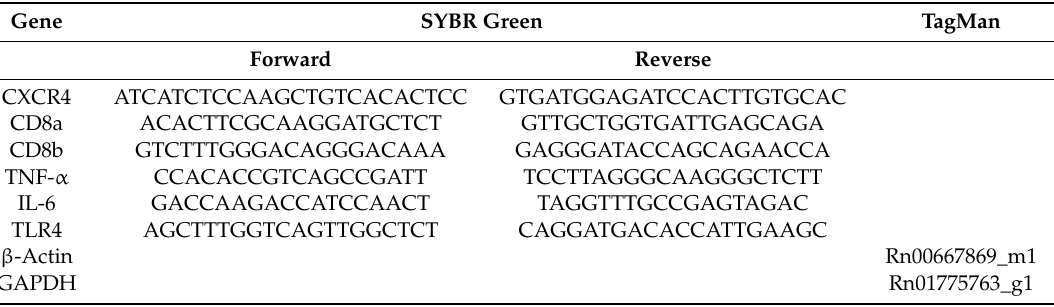
Table 2. Oligonucleotide primers used for quantitative